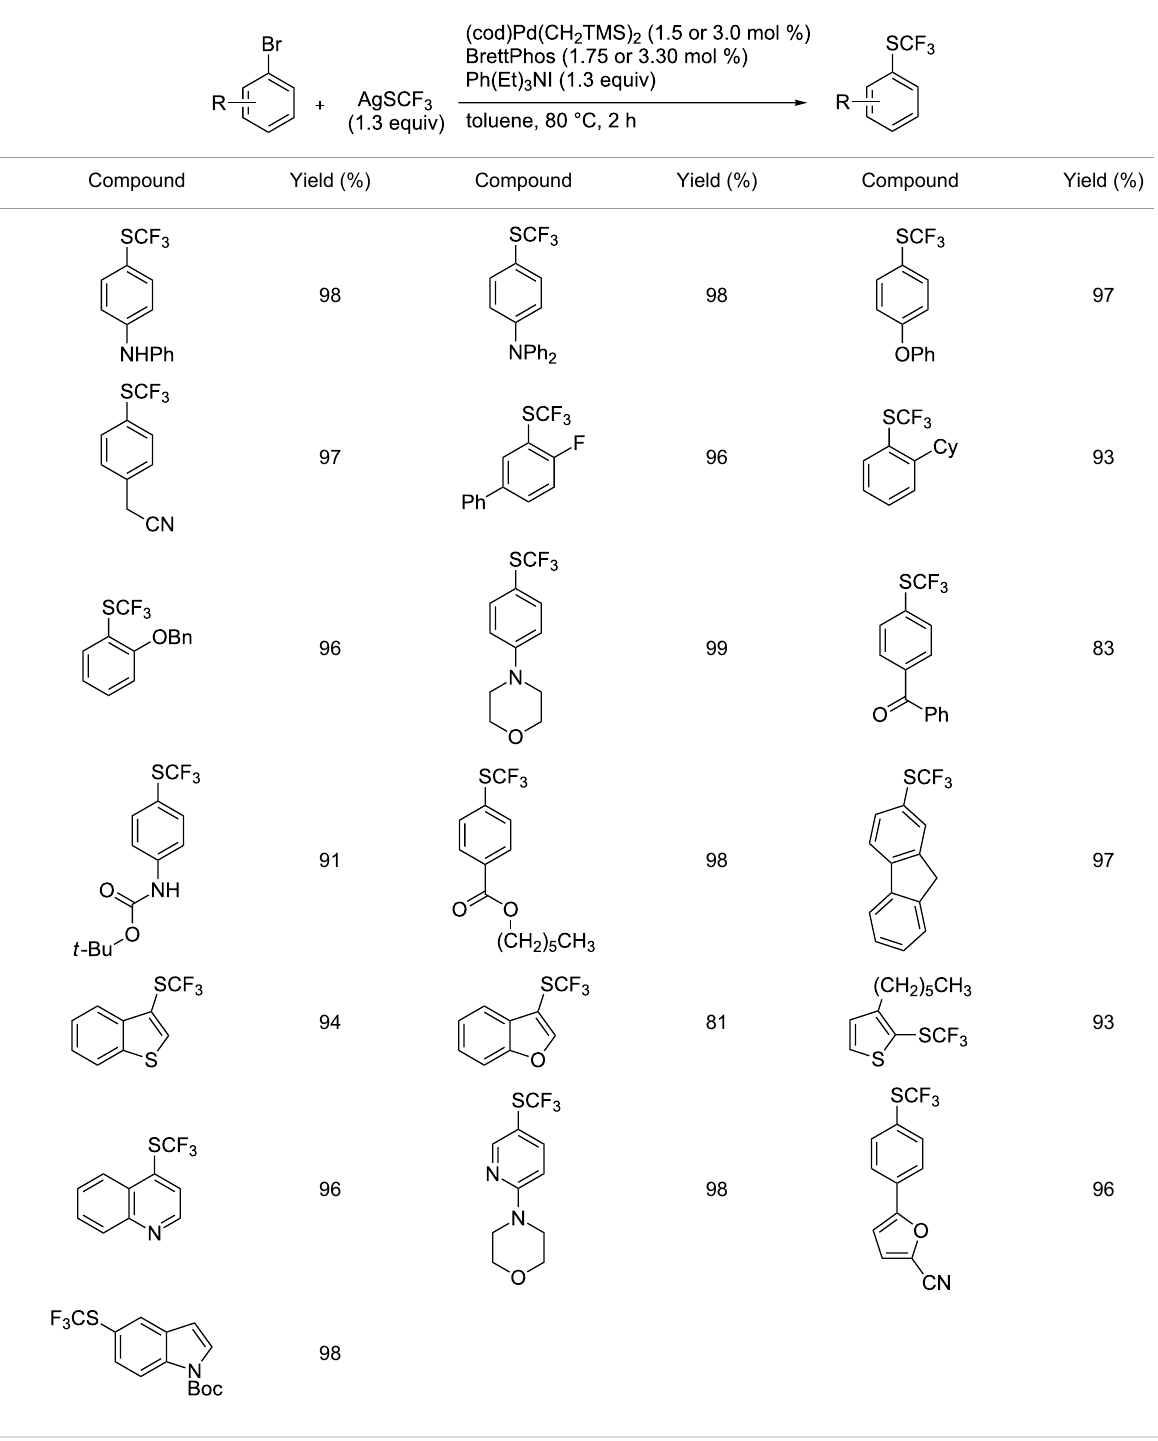
Table 42: Pd-catalyzed reaction of aryl bromides with trifluoromethylthiolate